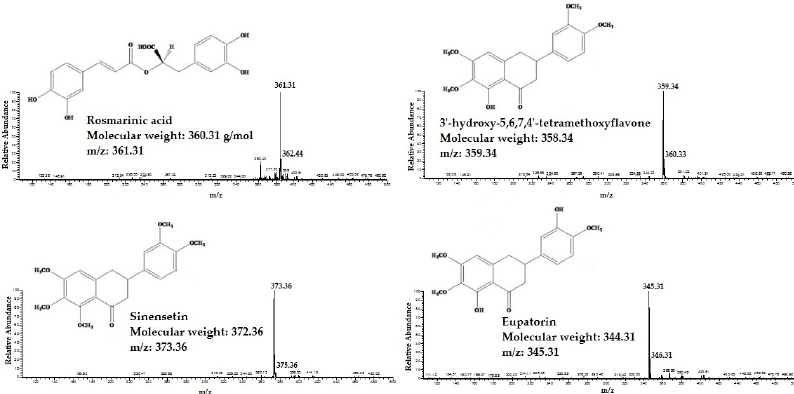
Figure 1. The High performance liquid chromatography-mass spectrometry (HPLC/MS) spectra of standard compounds: 3 (cid:48) -hydroxy-5,6,7,4 (cid:48) -tetramethoxyflavone, eupatorin, sinensetin and rosmarinic acid.